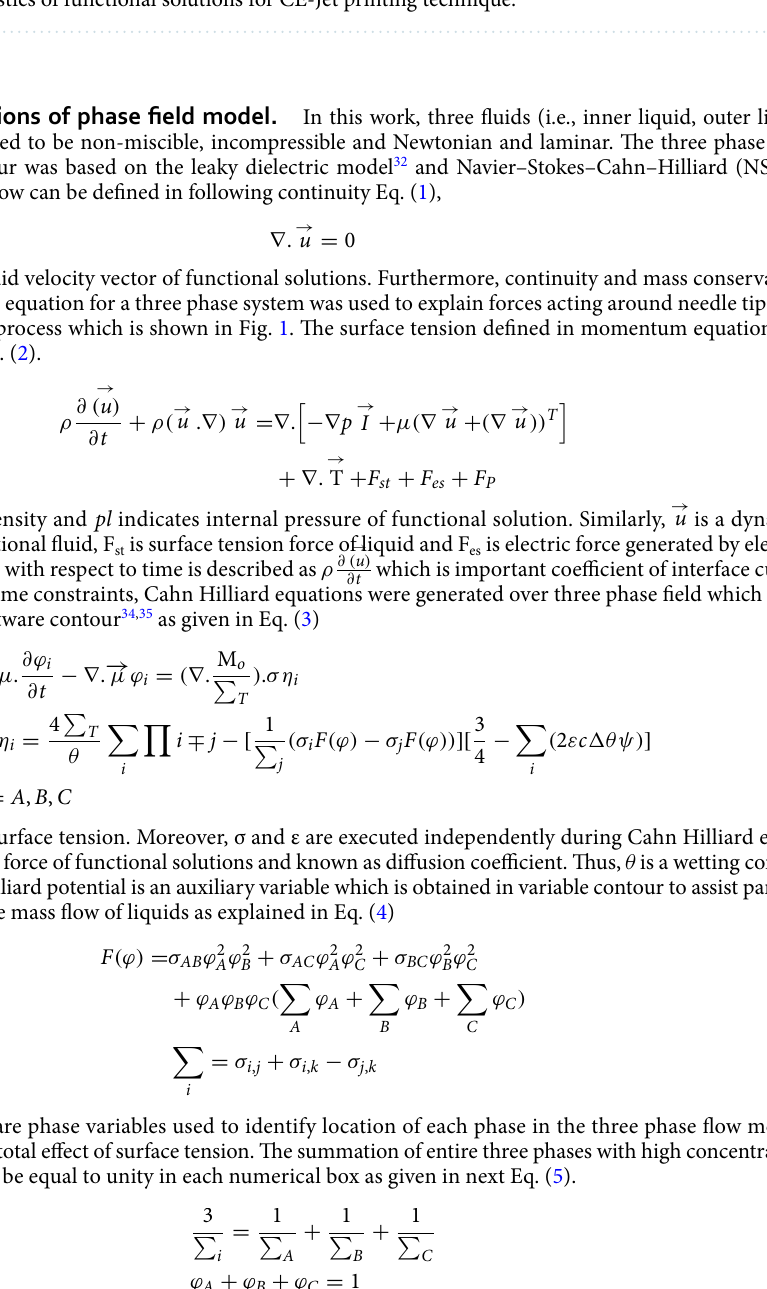
Table 1. Characteristics of functional solutions for CE-Jet printing